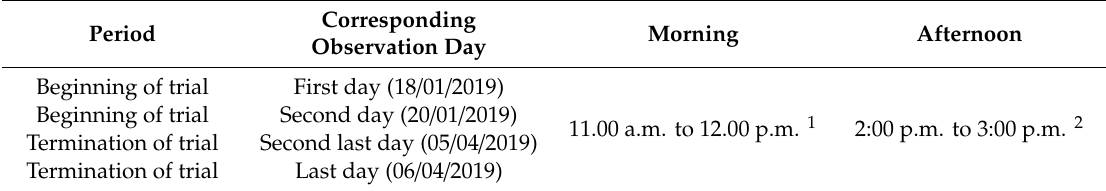
Table 4. Video observation